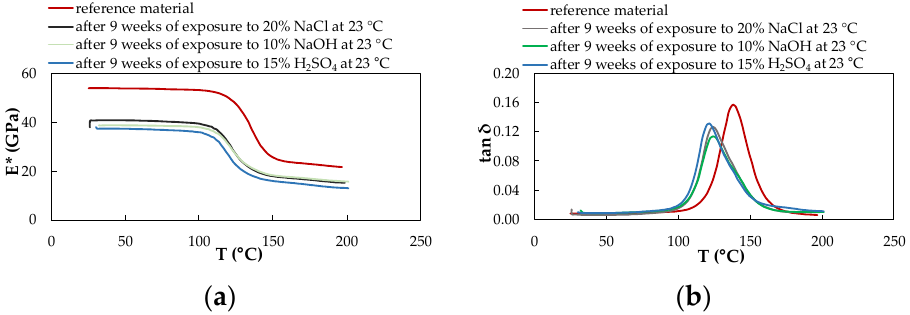
Figure 11. DMA of the CFRP composite evaluated depending on the influence of individual chemical environments at 23 °C; ( a ) complex modulus of elasticity; ( b ) tan delta.